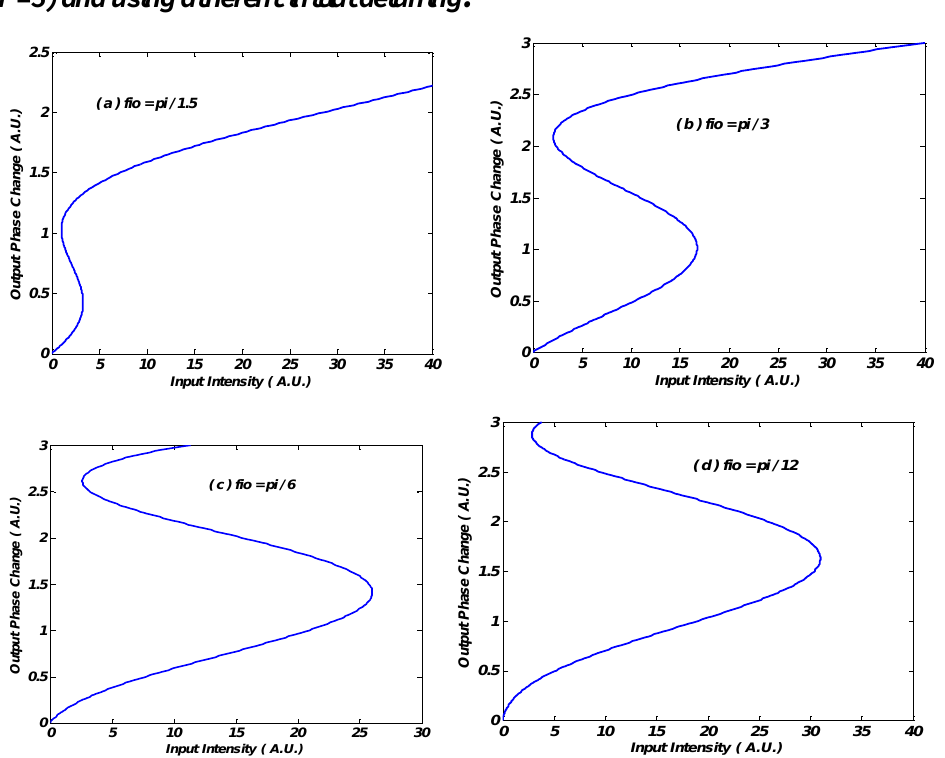
Fig.3: Input-Output characteristic for a nonlinear Fabry-Perot etalon of finesse value (F=5) and using different initial detuning.